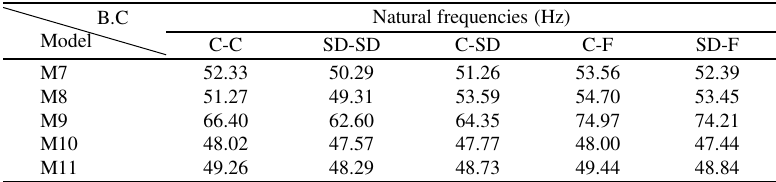
Table 9 Natural frequencies of separate cabin with different boundary